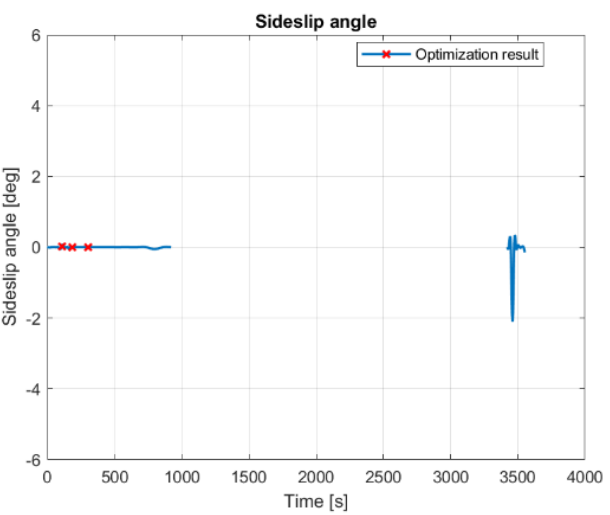
Figure 9. Sideslip angle in the optimized trajectory. The red marks indicate the staging or coasting phase.